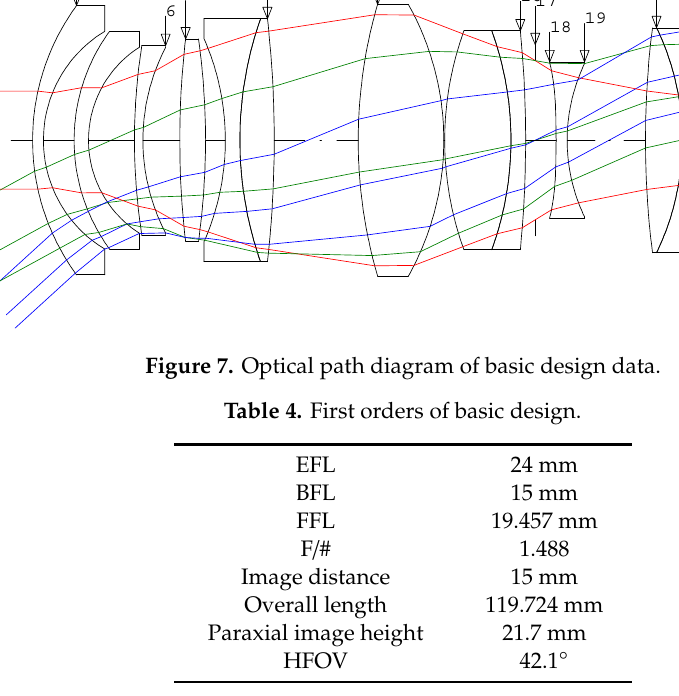
Figure 6. Degree change variances of the aspheric coefficient of the combined optical system. Table 3. Spot size and the spherical aberration change due to the radiation correction of the synthesized optical system.